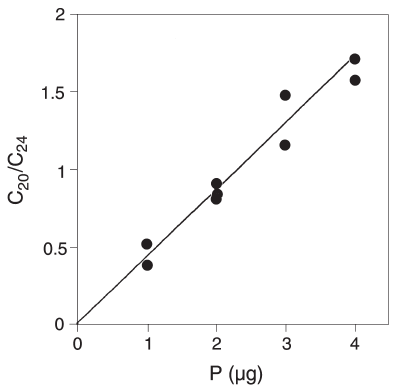
Figure 6. Standard curve for the quantification of allyl ether-bonded hydrocarbons by GLC after LiAlH 4 hydrogenolysis. The ratio C 20 / C 24 representsthe area ratio of the GLC profile integrated between the sample of geranylgeranyl hydrocarbon (C 20 ) to the known amount of internal standard (C 24 ). Abbreviation: P represents the amount of phosphate in the sample (2,3-di- O -geranylgeranyl- sn -glycerol-1- phosphate) that was subjected to